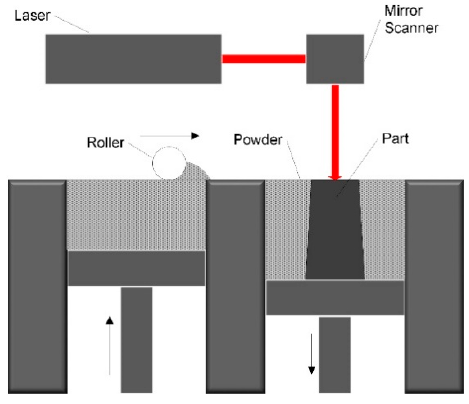
Figure 1. Schematic of selective laser melting (SLM) process.